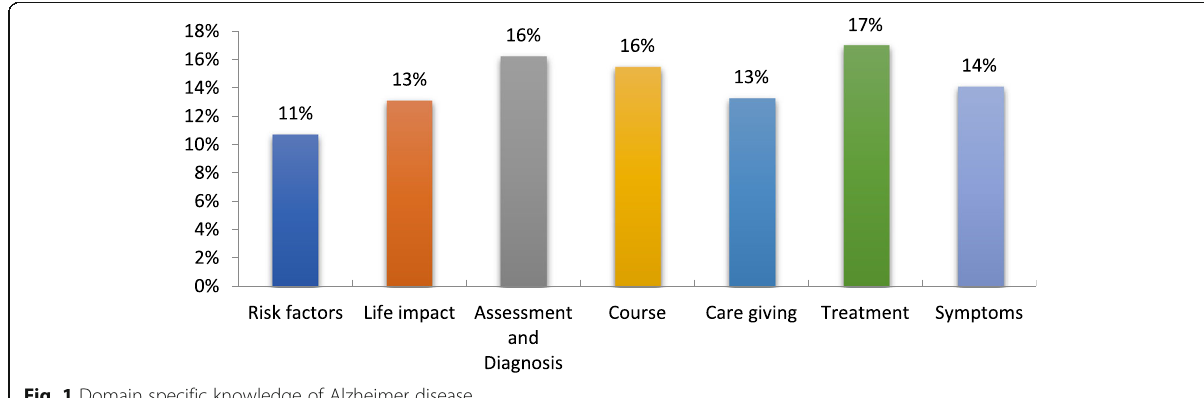
Fig. 1 Domain specific knowledge of Alzheimer disease